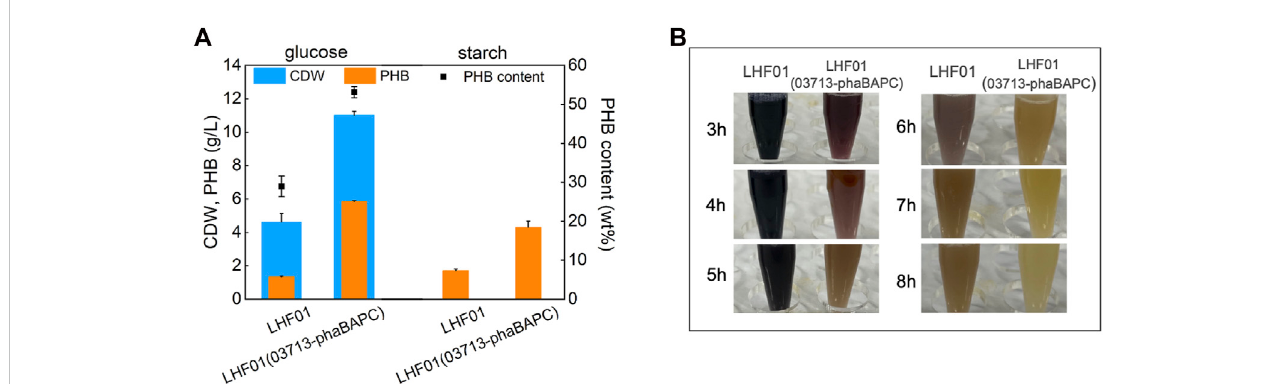
FIGURE 6 PHB production by V. alginolyticus strains using corn starch or glucose.Strains were cultivated in TYS50 medium supplemented with 20 g/L insoluble corn starch or glucose in shake fl asks at 37 ° C and 200 rpm. (A) , CDW, PHB production, and PHB content in LHF01 and LHF01 (03713-phaBAPC). (B) , starch consumption was indicated by adding iodine solution to the cultures.